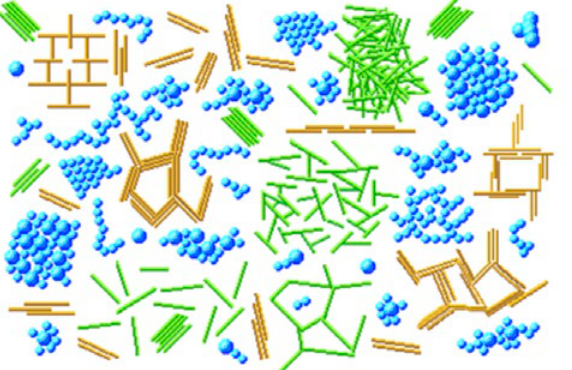
Figure 42. Natural sediment particles are attracted to each other by surface charge to form clusters and particle associations when they first precipitate.